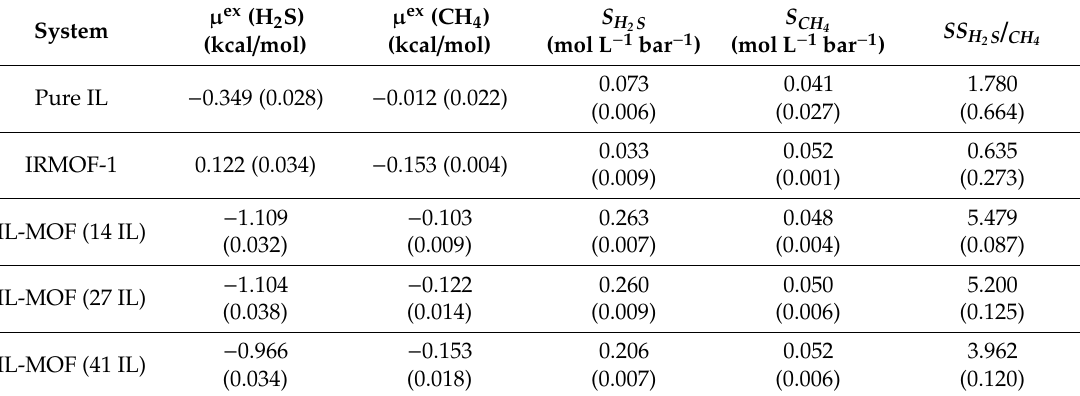
Table 3. Excess chemical potential ( µ ex ), solubility (S), and solubility selectivity (SS) of H 2 S and CH 4 inside the [Chl][SCN] / IRMOF-1 composite, comprising of di ff erent IL loadings at 298 K and 1 atm.